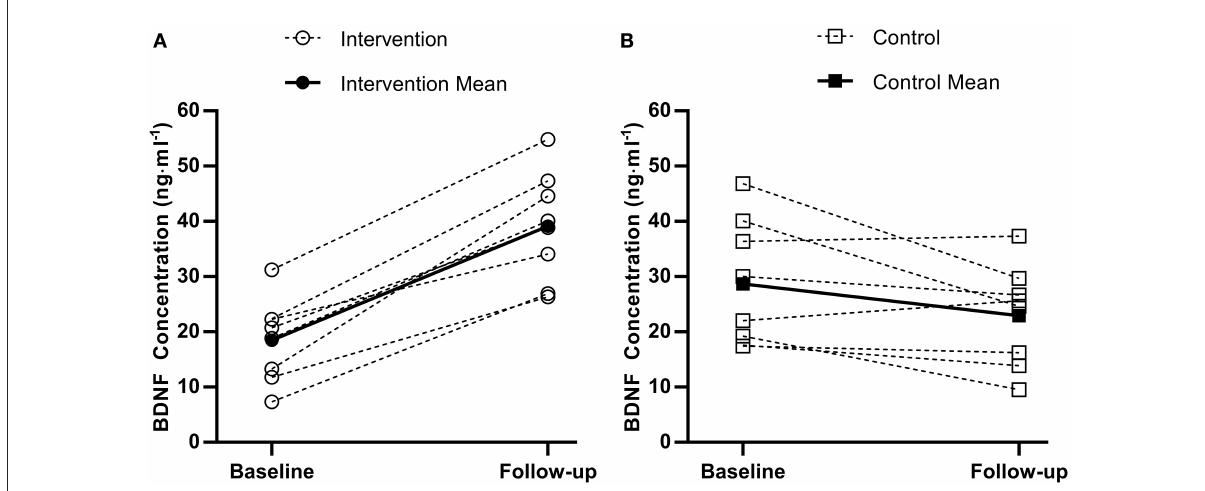
FIGURE2 Individual (dashed) and mean (solid) pre to post brain-derived neurotrophic factor (BDNF) changes for the experimental group (A) and control group (B)